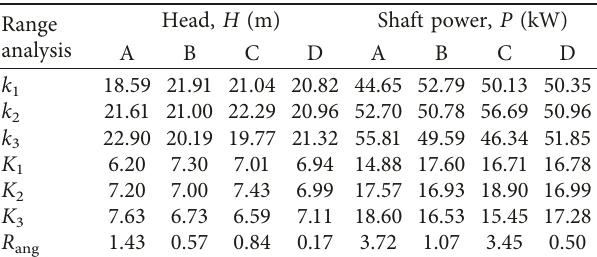
Table 6: Range analysis of the results on head and efficiency.